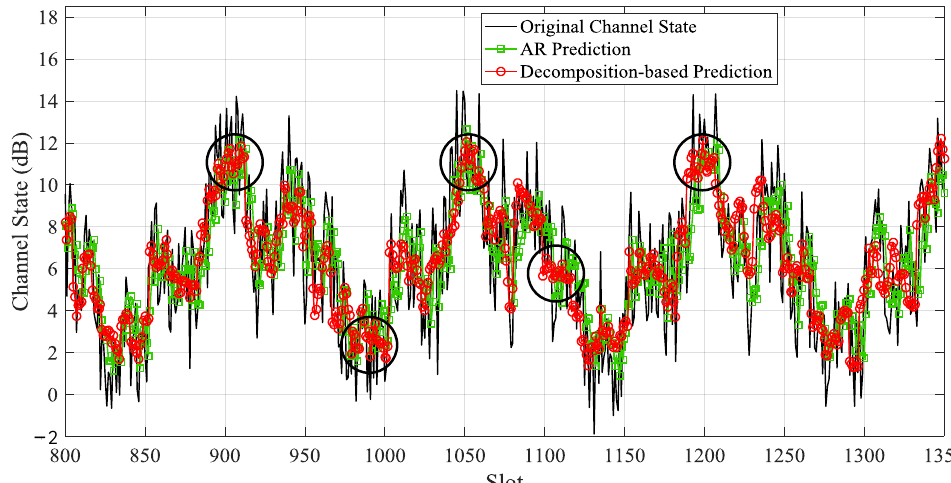
Figure 18. Predicted small-scale channel state of Data 1 by the decomposition-based prediction model and auto-regressive (AR) prediction.